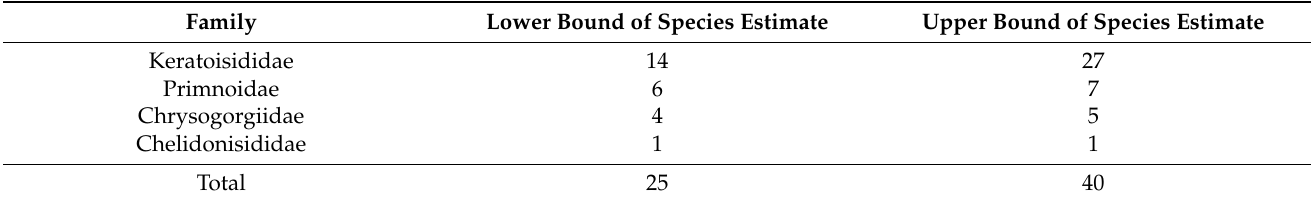
Table 4. Upper and lower bounds of the potential number of species per family. See Section 3.5 for the justification and reasoning for each